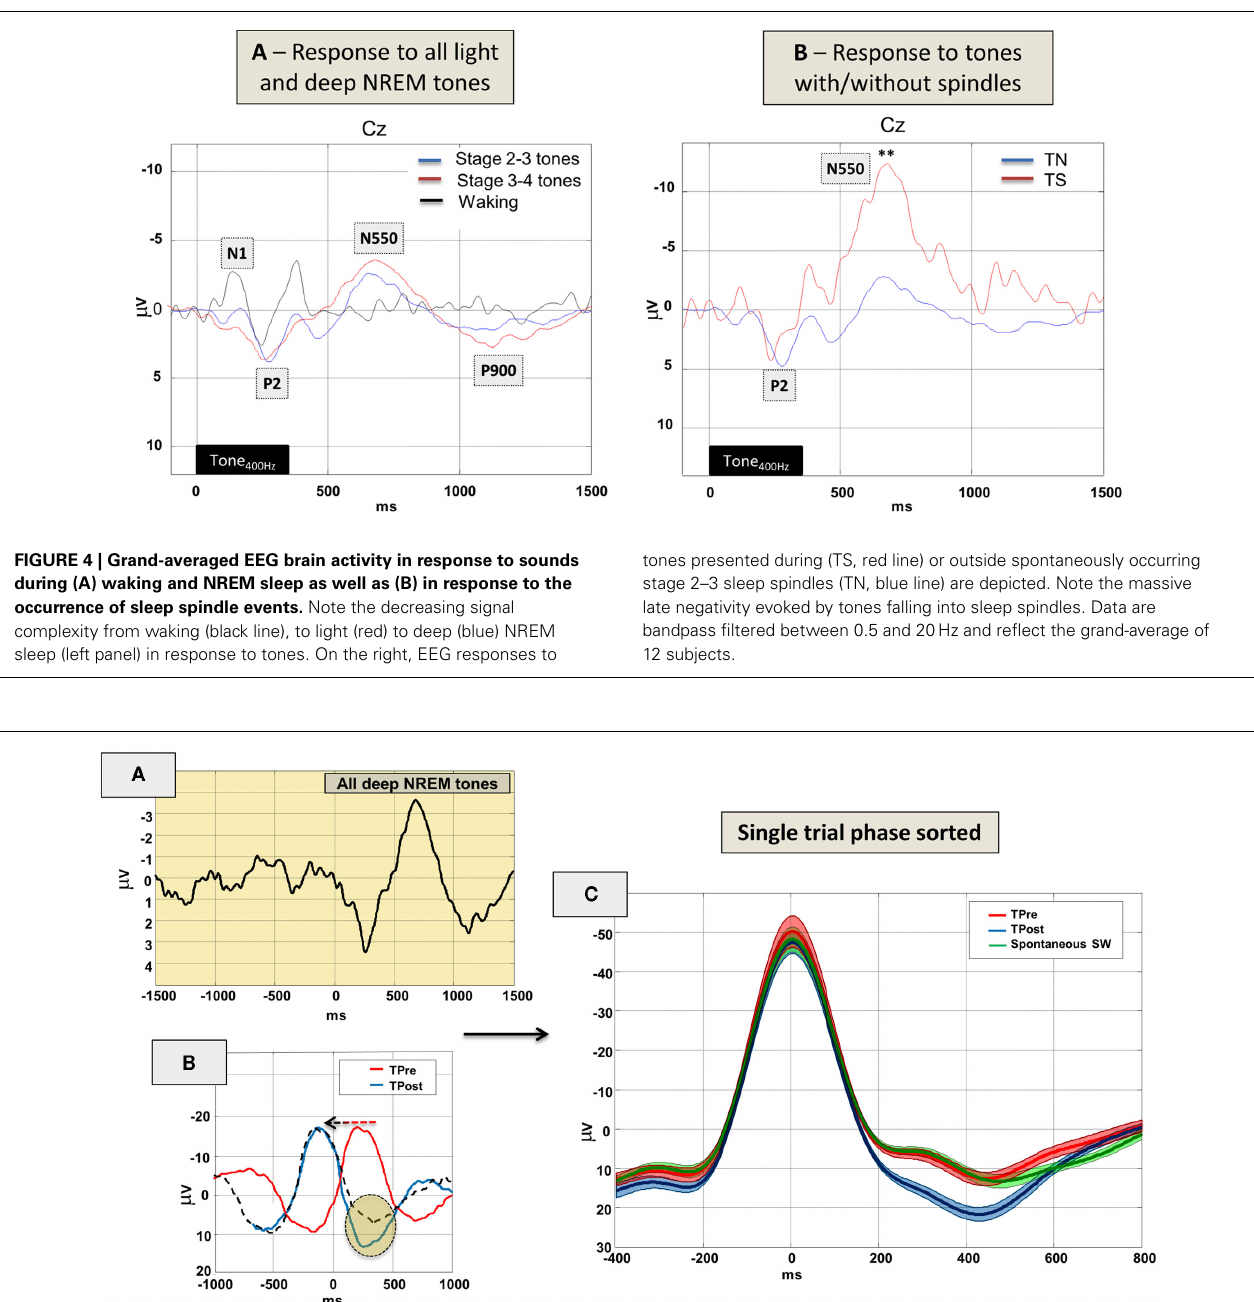
better comparison. Data are bandpass filtered between 0.5 and 20Hz and reflect the grand-average of 12 subjects.Time 0 is the tone onset. (C) Single trial phase-sorted and re-aligned EEG brain responses to sounds during deep NREM sleep. Note that latter analysis accentuates the amplitude as no time jitter is present when averagingTPre andTPost trials according to SW-peak negativity (rather than to tones) on a trial-by-trial basis. In (C) Time 0 is therefore marking the SW-peak negativity forTPre andTPost trials. Spontaneous slow-waves are plotted for comparison in green. Data are (zero-phase lag) low-pass filtered at 4Hz and error bars are overlaid at each sampling point. All potentials with negativity